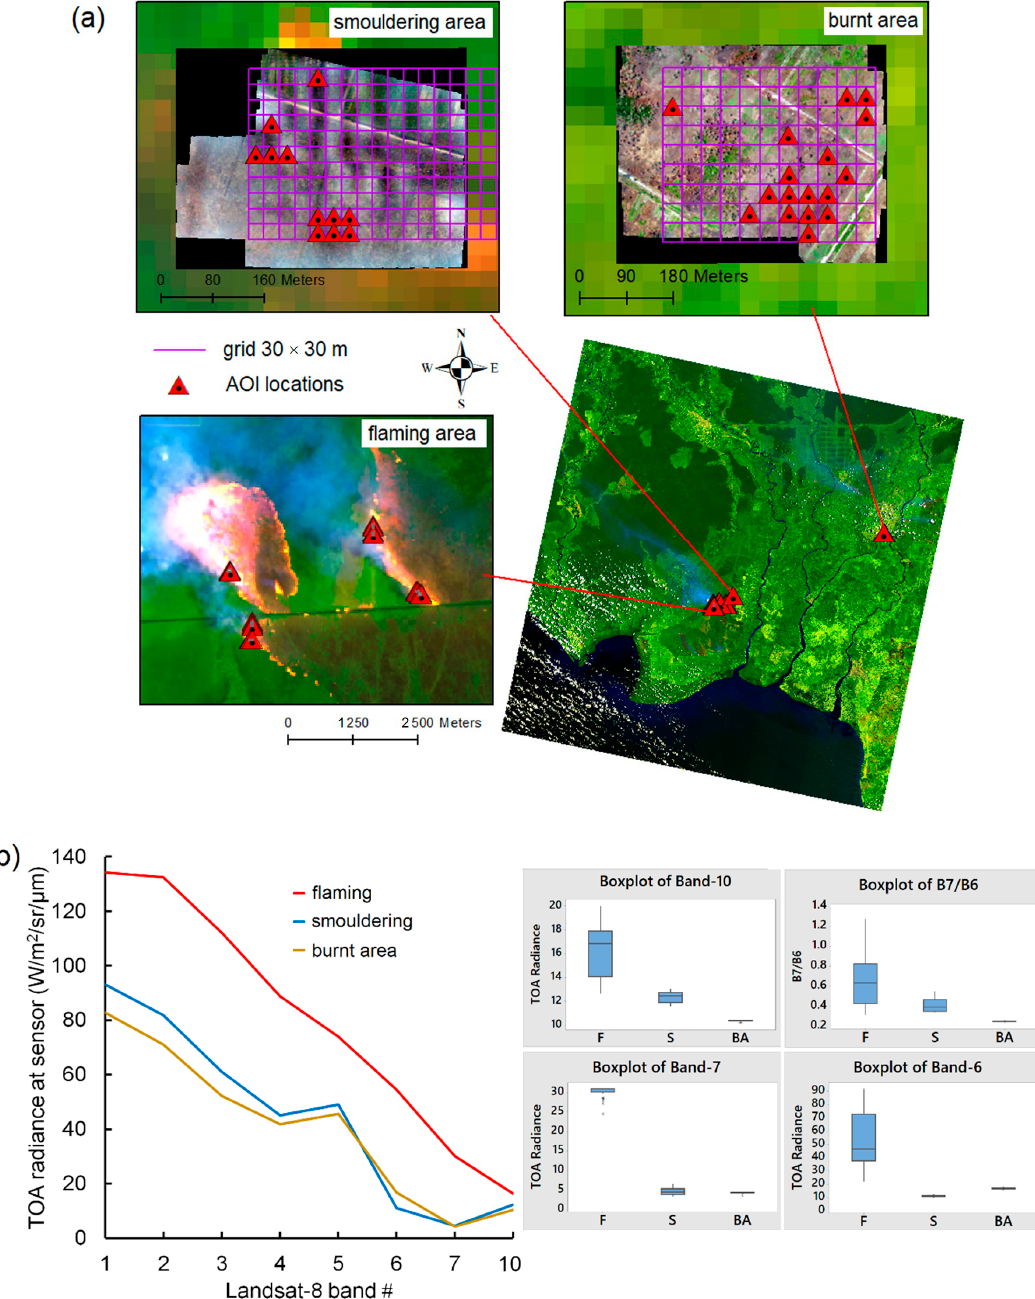
Figure 5. ( a ) Inset map of burnt area, smouldering and flaming area with area of interest (AOI) over Landsat-8 image; the AOI of burnt area and smouldering were selected based on drone image while flaming area based on obvious fire features on RGB Landsat-8 image ( b ) Profile of Top of Atmospheric (TOA) radiance of Landsat-8 bands for flaming, smouldering peatland, and burnt areas locations collected from ground truth data on 28 September 2018 to 1 October 2018. Smouldering locations were observed two days after Landsat-8 acquisition due to the longer proses of burning in smouldering peatlands. The Landsat-8 imagery was acquired on 28 September 2018 in Central Kalimantan (path/row of 118/62). Boxplots of band 10, band-7, band-6 and ratio of band-7 to band-6 of Landsat-8 are presented. The ratio of band-7 to band-6 shows a potential index for separating combustion and non-combustion areas. F, S, and BA represent flaming, smouldering and burnt areas respectively.